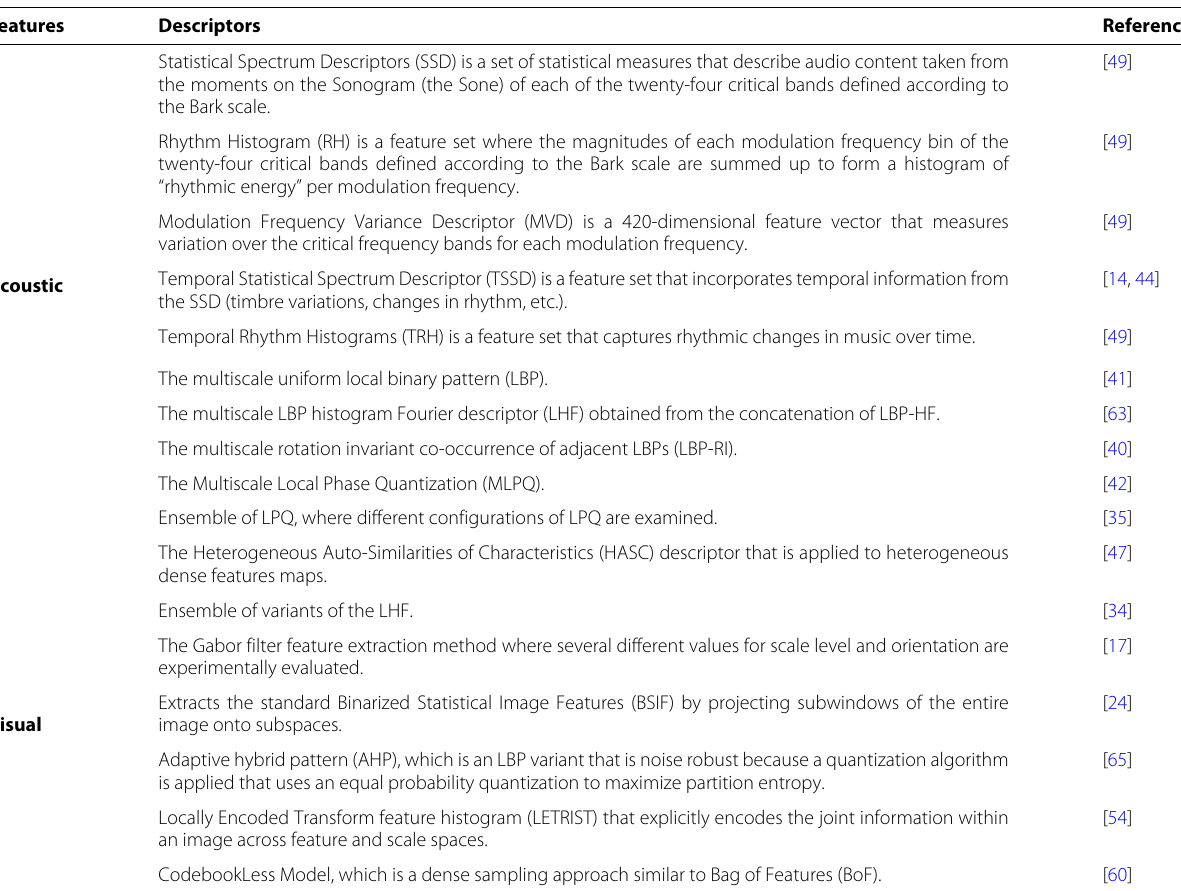
Table 1 Acoustic and visual handcrafted features